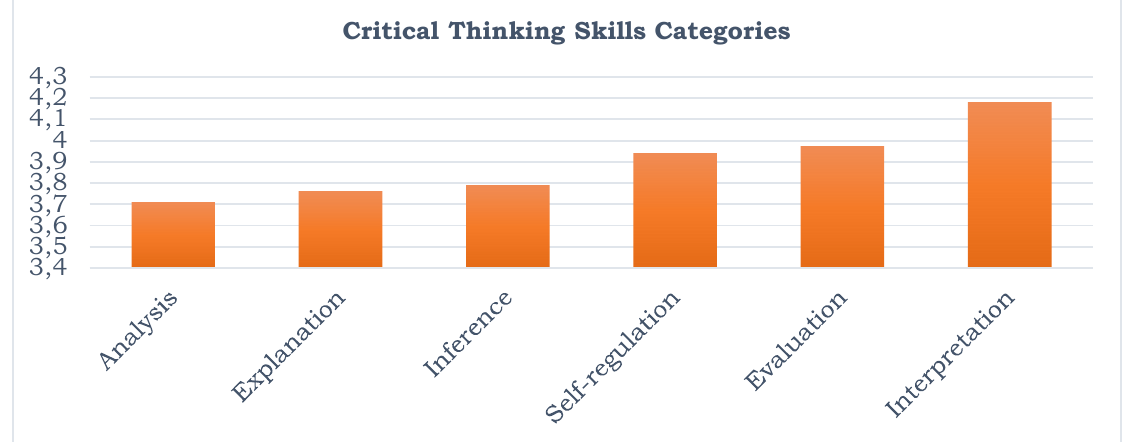
Figure 2. Students’ perceived critical thinking skills